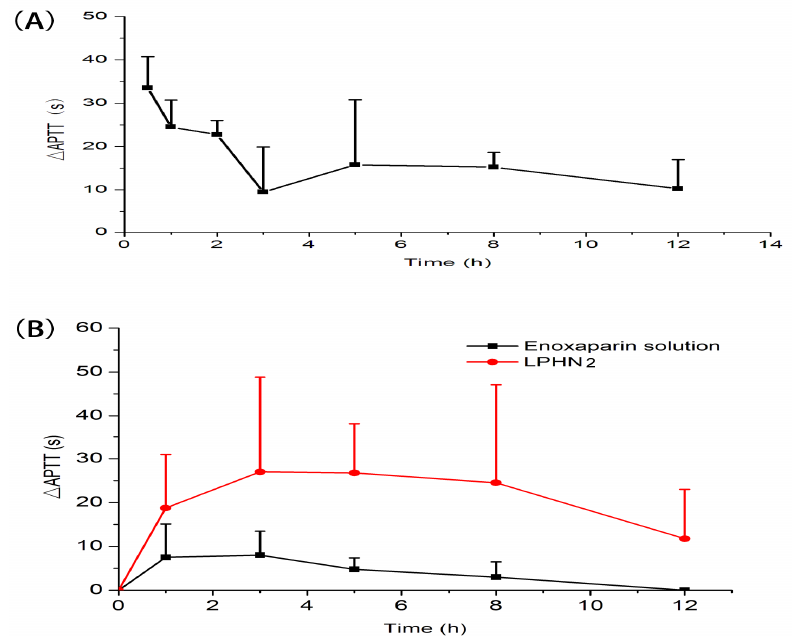
Figure 3. Mean ∆ activated partial thromboplastin time (APTT) over time after a single intravenous injection of enoxaparin solution at a dosage of 101 IU / kg ( A ), and oral administration of enoxaparin solution and enoxaparin-loaded LPHN2 at a dosage of 1010 IU / kg ( B ) ( n = 4). Table 2. Main pharmacokinetic parameters after peroral administration of enoxaparin formulations in rats at a dosage of 1010 IU/kg ( n = 4). * p < 0.05 represents a significant improvement in absolute bioavailability in comparison with enoxaparin solution (p.o.).